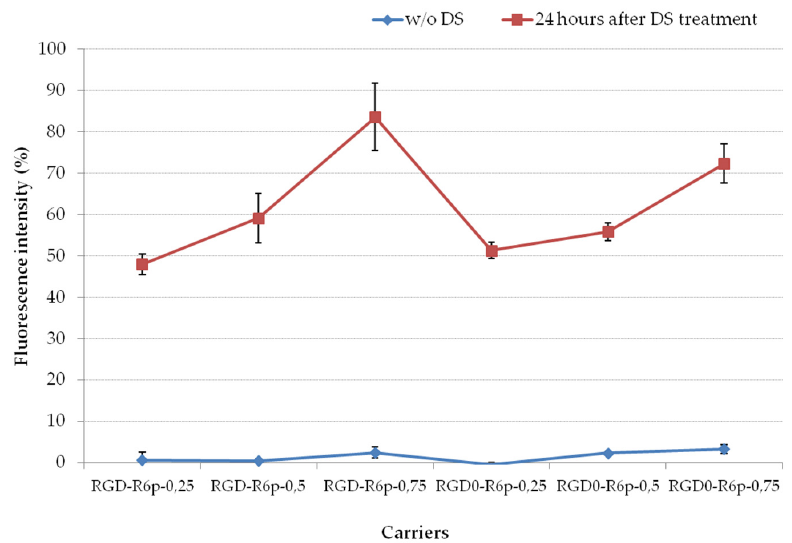
Figure 5. Relaxation of peptide/DNA complexes after 24 h of DS treatment in three-fold charge excess. Values are the mean ± SEM of the mean of triplicates.